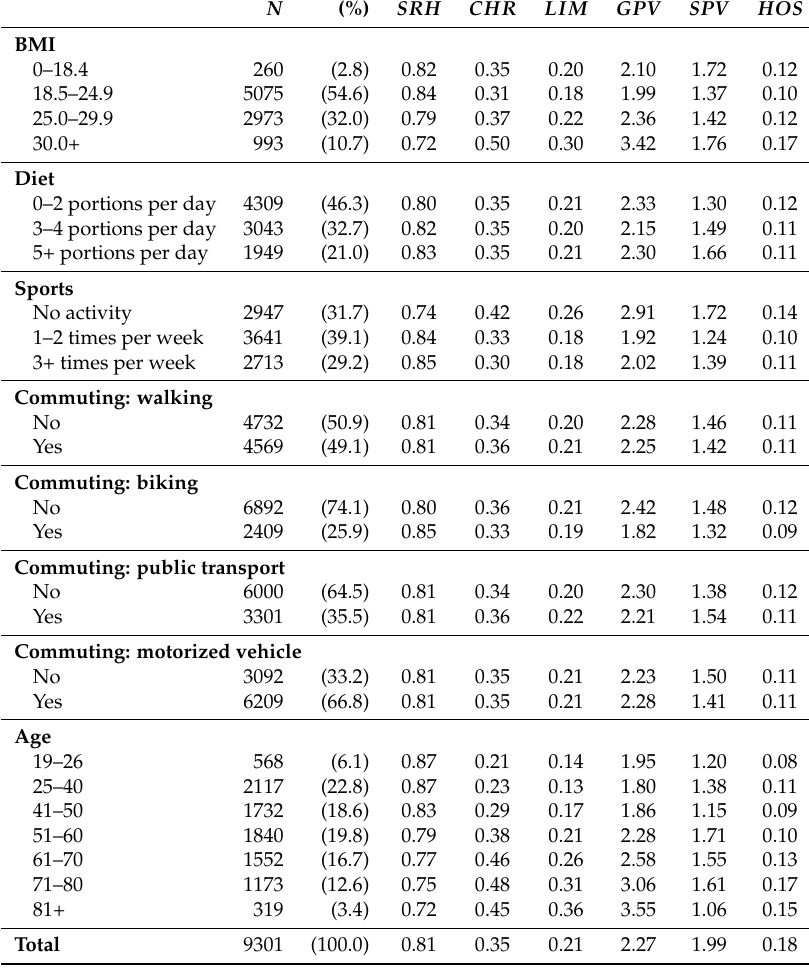
Table 2. Descriptive statistics of the exogenous characteristics affecting